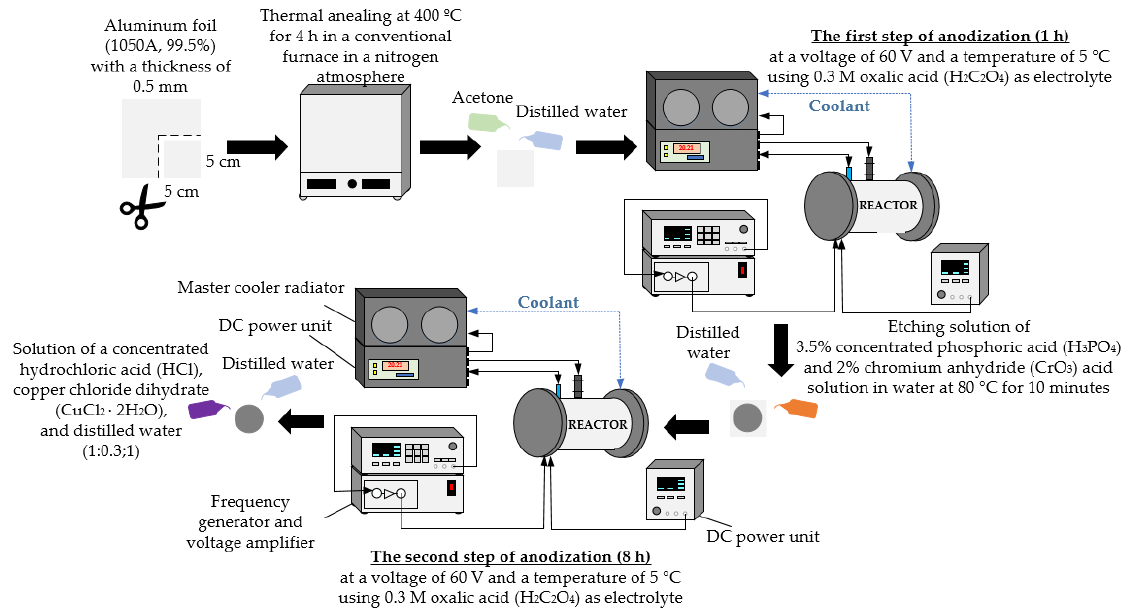
Figure 2. Illustration of the two ‐ step anodization process. Under the same anodization conditions, AAO membranes were fabricated using high ‐ frequency excitation during the first and second steps of anodization. The high ‐ fre ‐ quency oscillations were generated using a piezoceramic ring, which was excited by the signal from the frequency generator and the voltage amplifier. A piezoceramic ring was installed inside the reactor.